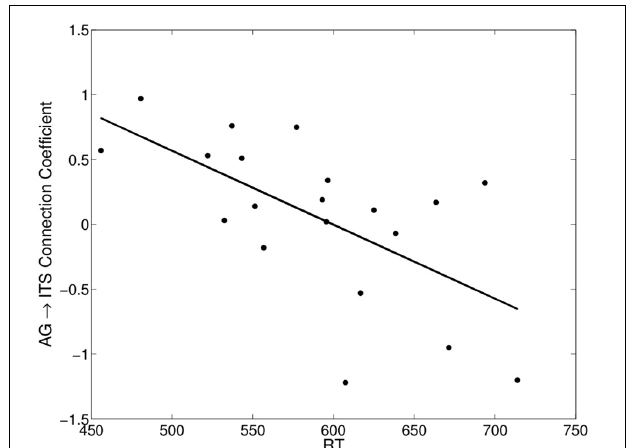
FIGURE 5 | Significant negative correlation between each participant’s mean RT on correct reading aloud trials and the angular gyrus → inferior temporal sulcus connection coefficient (group connection shown in Figure